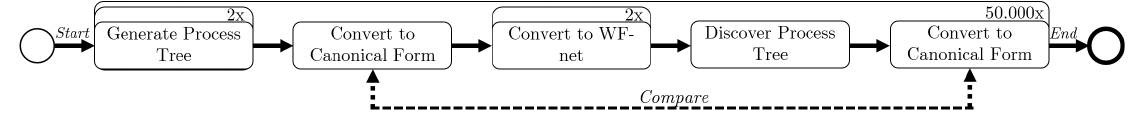
Figure 13. Overview of the experimental setup of the conducted